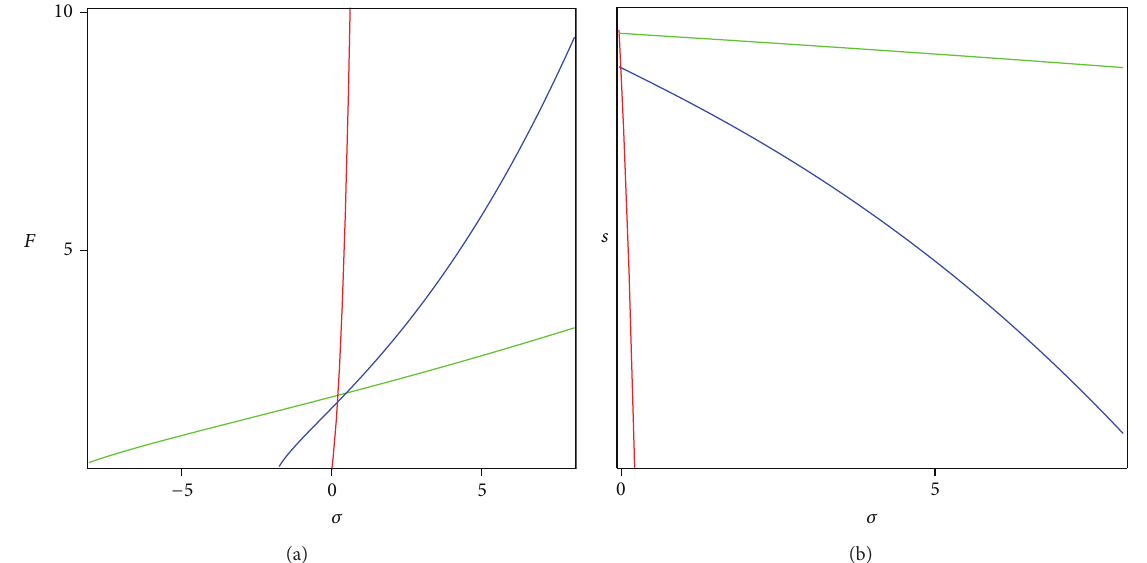
Figure 1: (a) Free energy in terms of 𝜎 . (b) Entropy in terms of 𝜎 . We fix 𝜅 = 1 , 𝜔 = 2 , and 𝑇 = 0.2 (red line), 𝑇 = 1 (blue line), and 𝑇 = 2 (green